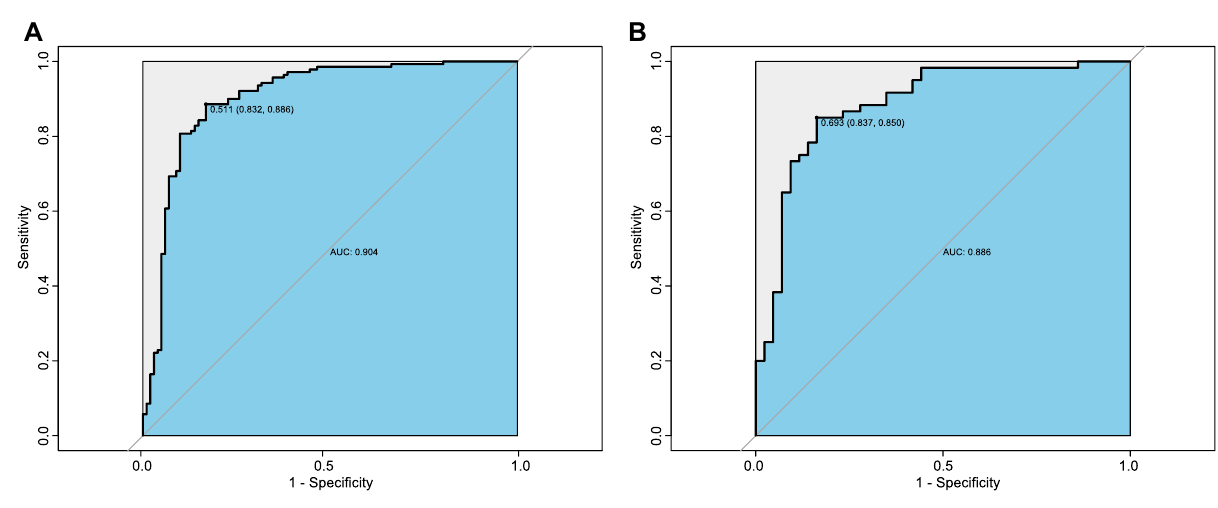
Figure 2. Differential capability of the nomogram. (A) ROC curve based on obtained potential risk factors identified by multivariate logistic regression analysis showing discrimination rate for PLA2R negative MN and MCD in the training group. (B) ROC curve based on obtained potential risk factors identified by multivariate logistic regression analysis showing discrimination rate for PLA2R negative MN and MCD in the test